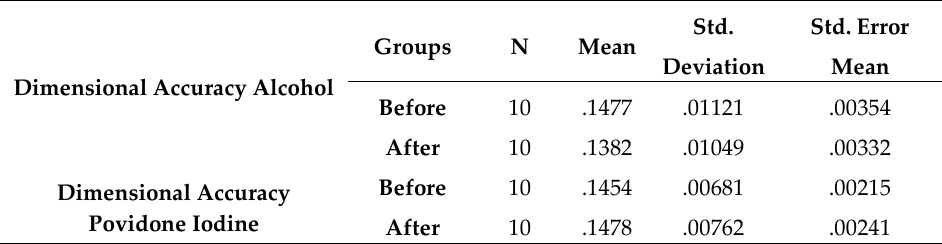
Table (1): summary statistics of dimensional accuracy test